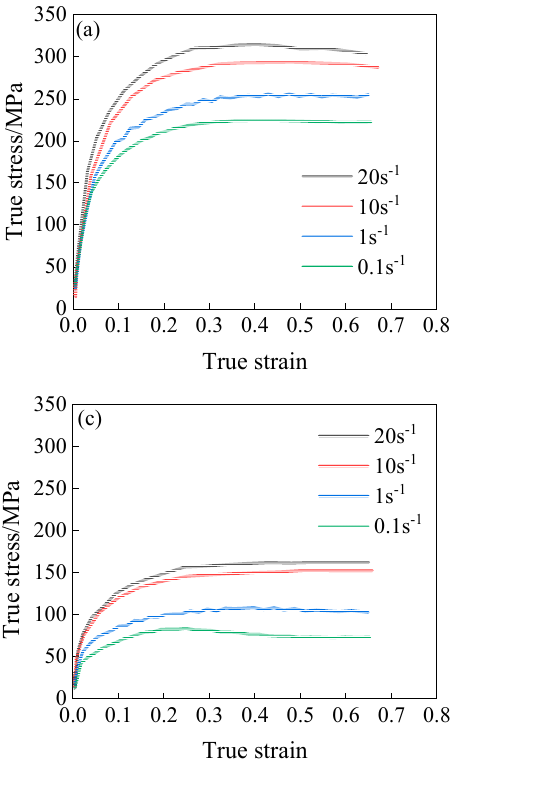
Figure 3. True stress-strain curves of 34CrNi3Mo steel, ( a ) T = 1073 K, ( b ) T = 1223 K, ( c ) T = 1323 K, ( d ) T = 1373K.